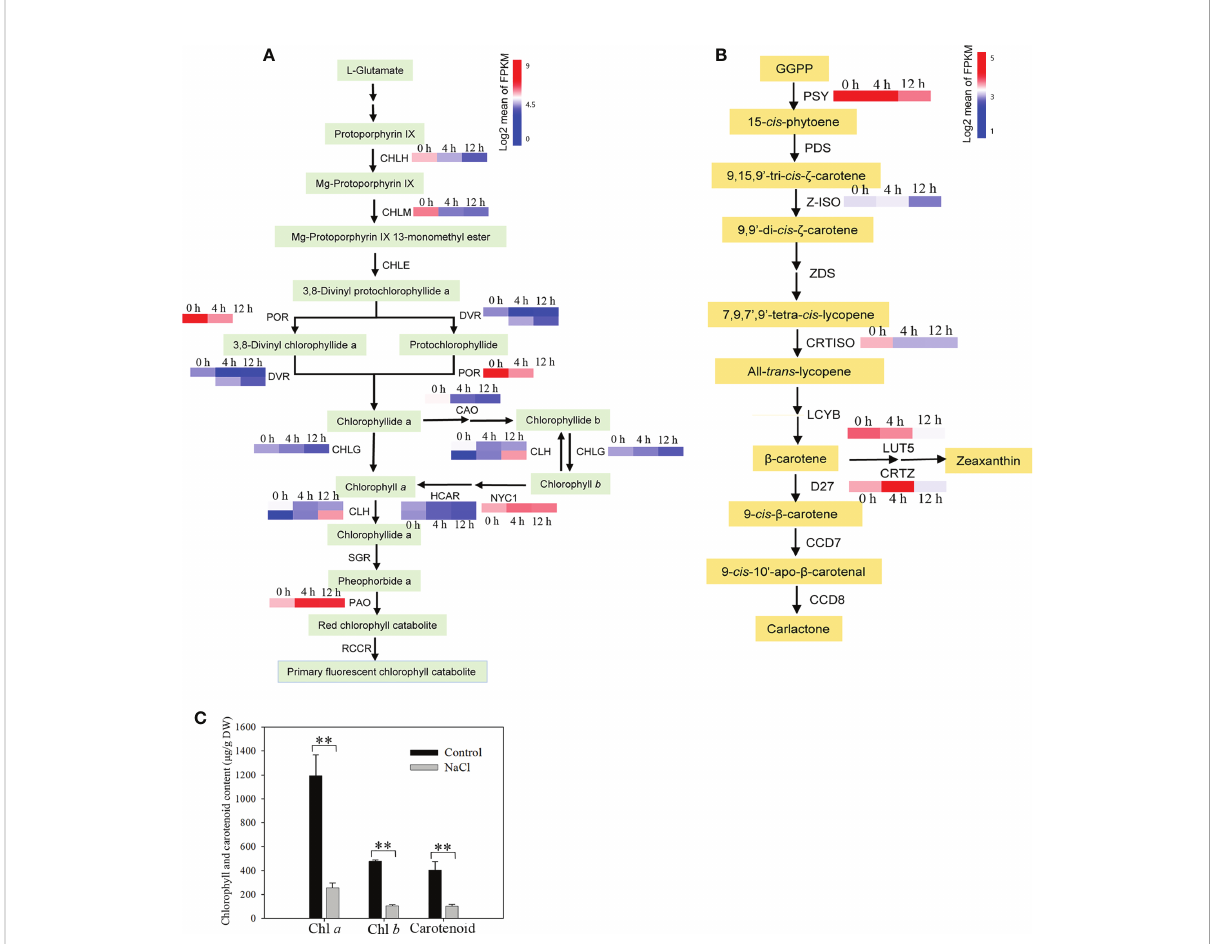
FIGURE 6 Analysis of the content of photosynthetic pigments and their metabolic pathway genes after salt treatment. (A) Analysis of expression of genes related to the Chl metabolic pathway. CHLH, magnesium chelatase subunit H; CHLM, magnesium-protoporphyrin O -methyltransferase; CHLE, magnesium-protoporphyrin IX monomethyl ester (oxidative) cyclase; POR, protochlorophyllide reductase; DVR, divinyl chlorophyllide a 8-vinyl- reductase; CHLG, chlorophyll/bacteriochlorophyll a synthase; CAO, chlorophyllide a oxygenase; CLH, chlorophyllase; NYC1, chlorophyll(ide) b reductase 1; HCAR, 7-hydroxymethyl chlorophyll a reductase; SGR, magnesium dechelatase; PAO, pheophorbide a oxygenase; RCCR, red chlorophyll catabolite reductase. (B) Changes in carotenoid biosynthetic pathway genes in response to salt stress. GGPP, geranylgeranyl diphosphate; PSY, 15- cis -phytoene synthase; PDS, 15- cis -phytoene desaturase; Z-ISO, z -carotene isomerase; ZDS, z -carotene desaturase; CRTISO, carotene cis - trans isomerase; LCYB, lycopene b -cyclase; LUT5, b -ring hydroxylase; CRTZ, b -carotene 3-hydroxylase; D27, b -carotene isomerase; CCD7, 9- cis - b -carotene 9 ’ ,10 ’ -cleaving dioxygenase; CCD8, carlactone synthase/all- trans -10 ’ -apo- b -carotenal 13,14-cleaving dioxygenase. The Chl metabolic pathway and carotenoid biosynthetic pathway were redrawn based on ‘ porphyrin and chlorophyll metabolism ’ and ‘ carotenoid biosynthesis ’ pathways in the KEGG database (https://www.kegg.jp/). Genes whose expression changed signi fi cantly in at least one time point after salt treatment are shown. (C) Content of chlorophyll (Chl) a , Chl b and carotenoids. Roots were harvested from plantlets after 250 mM NaCl treatment for two weeks. Bars indicate means ± standard deviation of three replicates. ** indicates signi fi cant differences at P < 0.01 according to the Dunnett test. DW, dry